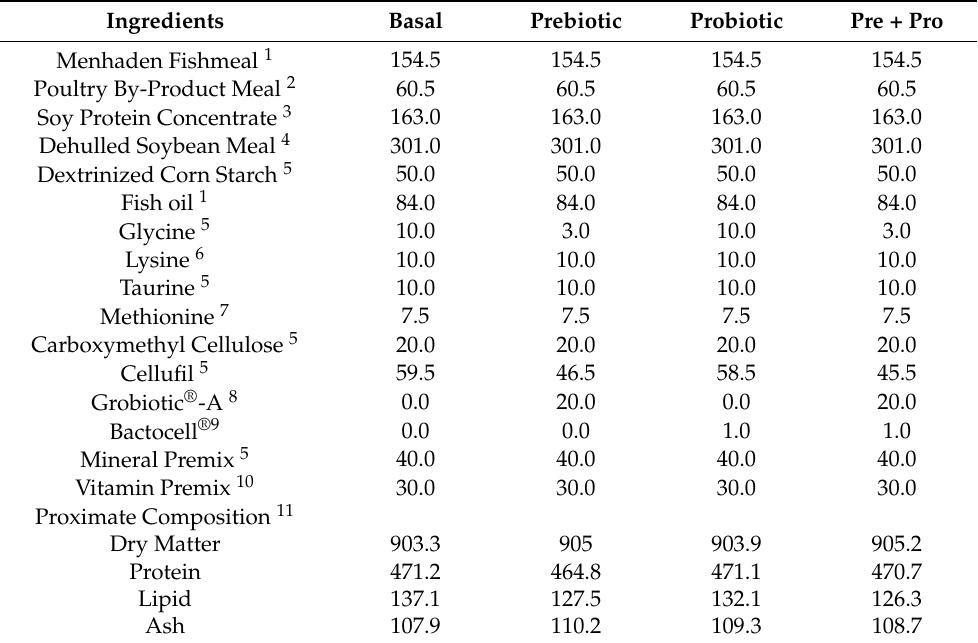
Table 1. Formulations and analyzed proximate composition of the experimental diets. Values are expressed as g/1000 g of diet on a dry-matter